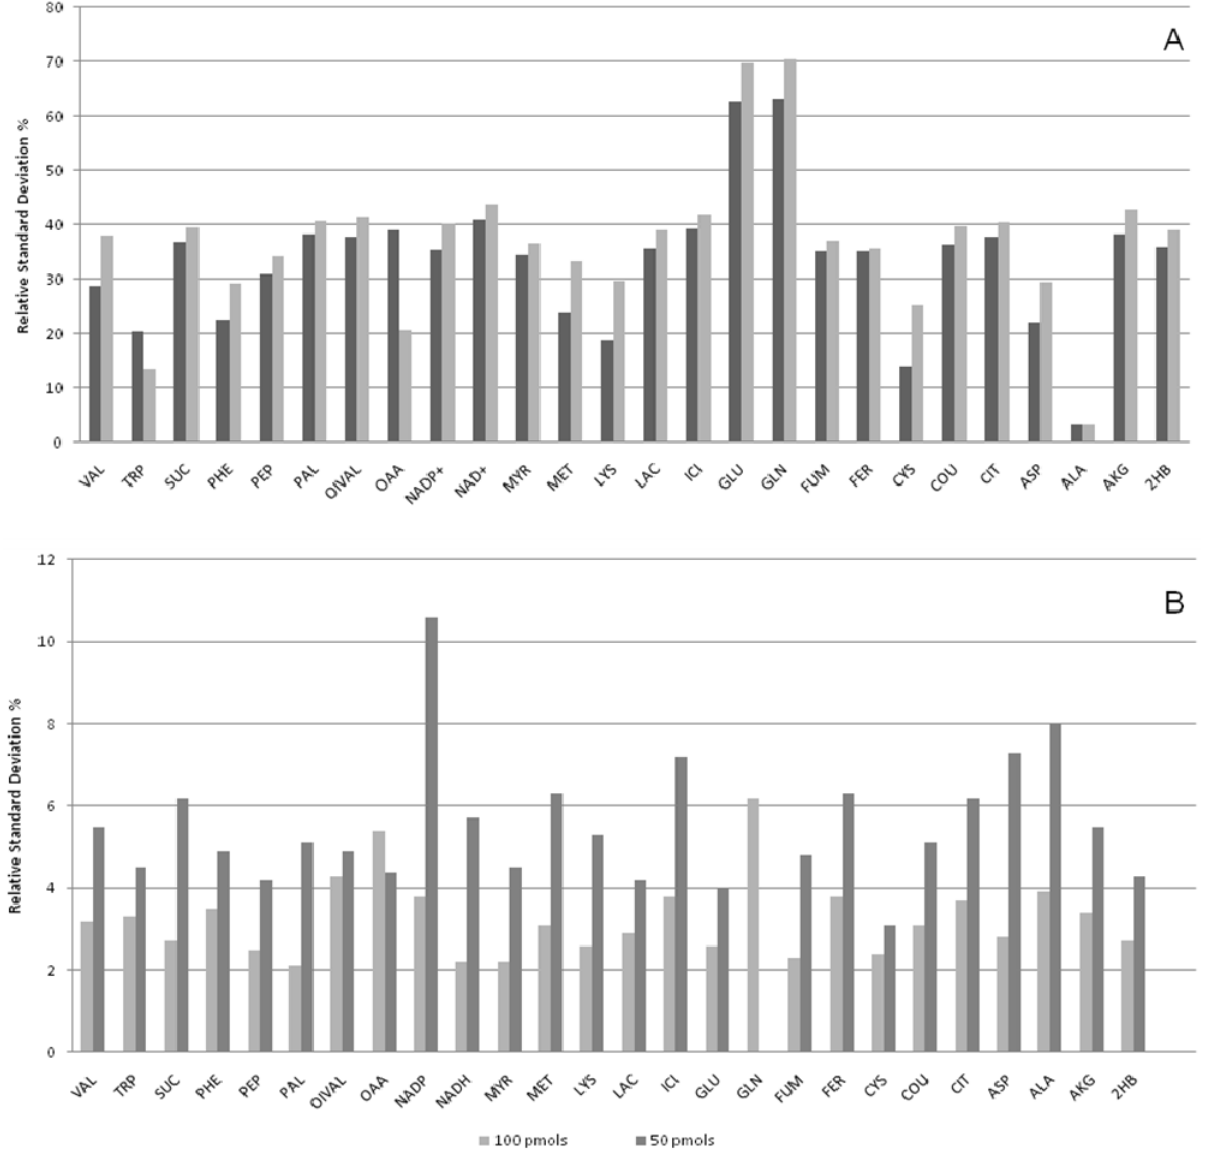
Figure 3. Relative standard deviations of the GC peak areas of metabolite derivatives analyzed every four hours during 72 hours. ( A ) Silylation (TMS); ( B ) Alkylation (MCF). Legend shows concentration of metabolites per samples. See Table 1 for metabolite